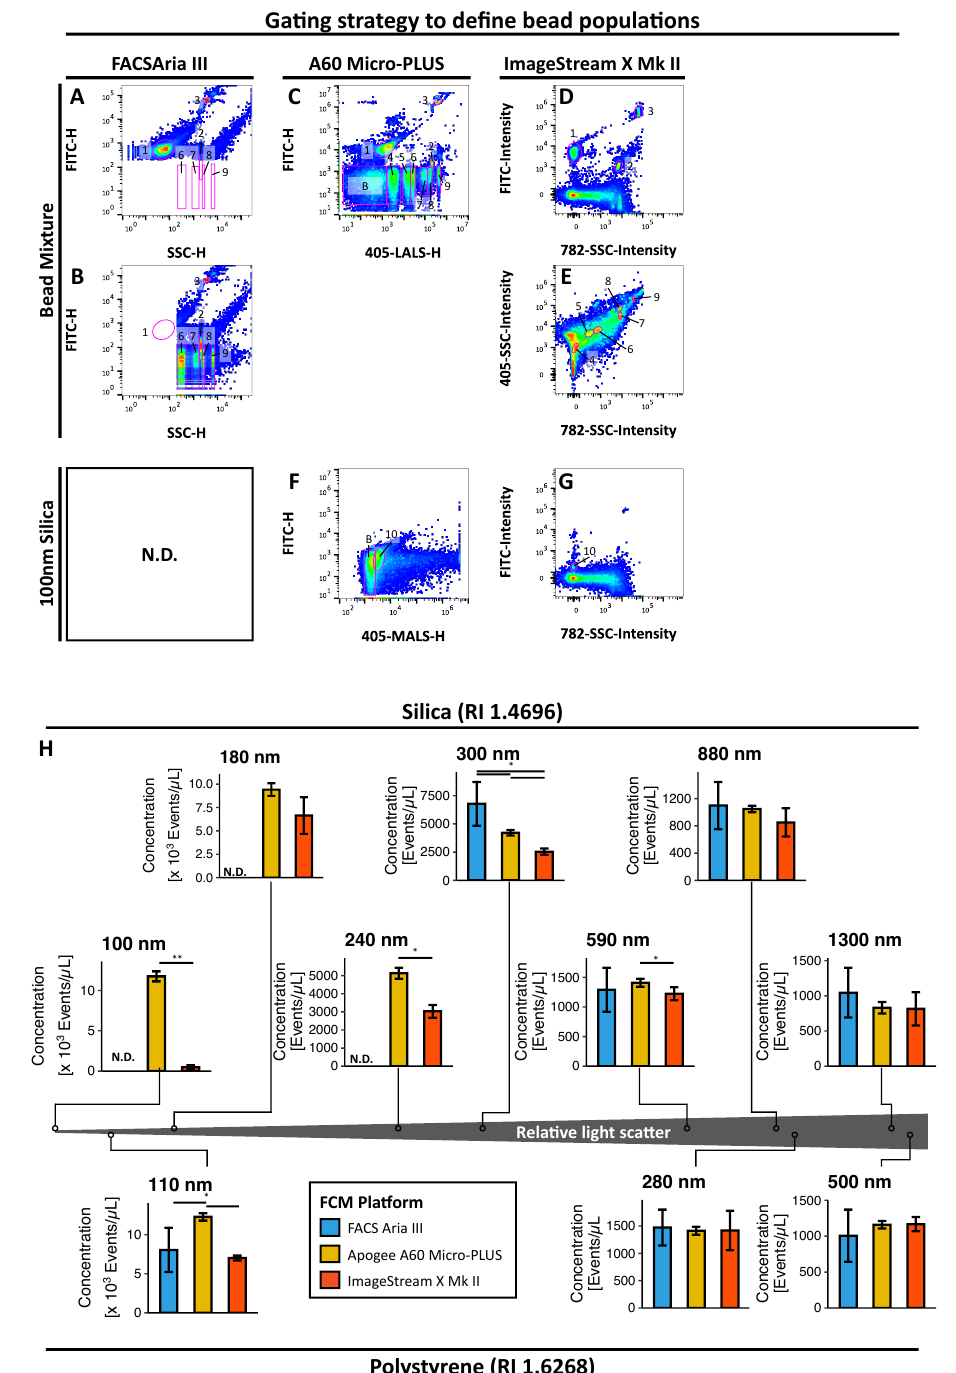
Figure 2. Detection and quantification of nanospheres with different refractive indices. ( A – G ) Gating strategy to define each nanosphere population in the bead mixture on ( A ) FACS Aria III for triggering in the FITC and ( B ) SSC, ( C ) Apogee A60 Micro-PLUS and ( D , E ) ImageStream X Mk II. ( F , G ) Gating strategy to define dimly FITC fluorescent 100 nm silica nanospheres on ( F ) Apogee A60 Micro-PLUS and ( G ) ImageStream X Mk II. ( H ) Concentrations of silica (top) and fluorescent polystyrene (bottom) nanosphere populations measured by each of the four platforms with an indication to their relative light scatter. Results are depicted as mean (bar) ± 1SD (error bars) for n = 5 observations of each nanosphere population acquired over the course of five analysis days. Numbers in A-E represent different nanosphere populations as follows: 1: Ps110 nm; 2: Ps280 nm; 3: Ps580 nm; 4: Si180 nm; 5: Si240 nm; 6: Si300 nm; 7: Si590 nm; 8: Si880 nm; 9: Si1300 nm; 10: Si100 nm; B: Background. *: p < 0.05; **: p < 0.01. N.D.: Not detected; RI: Refractive Index; MALS: Medium angle light